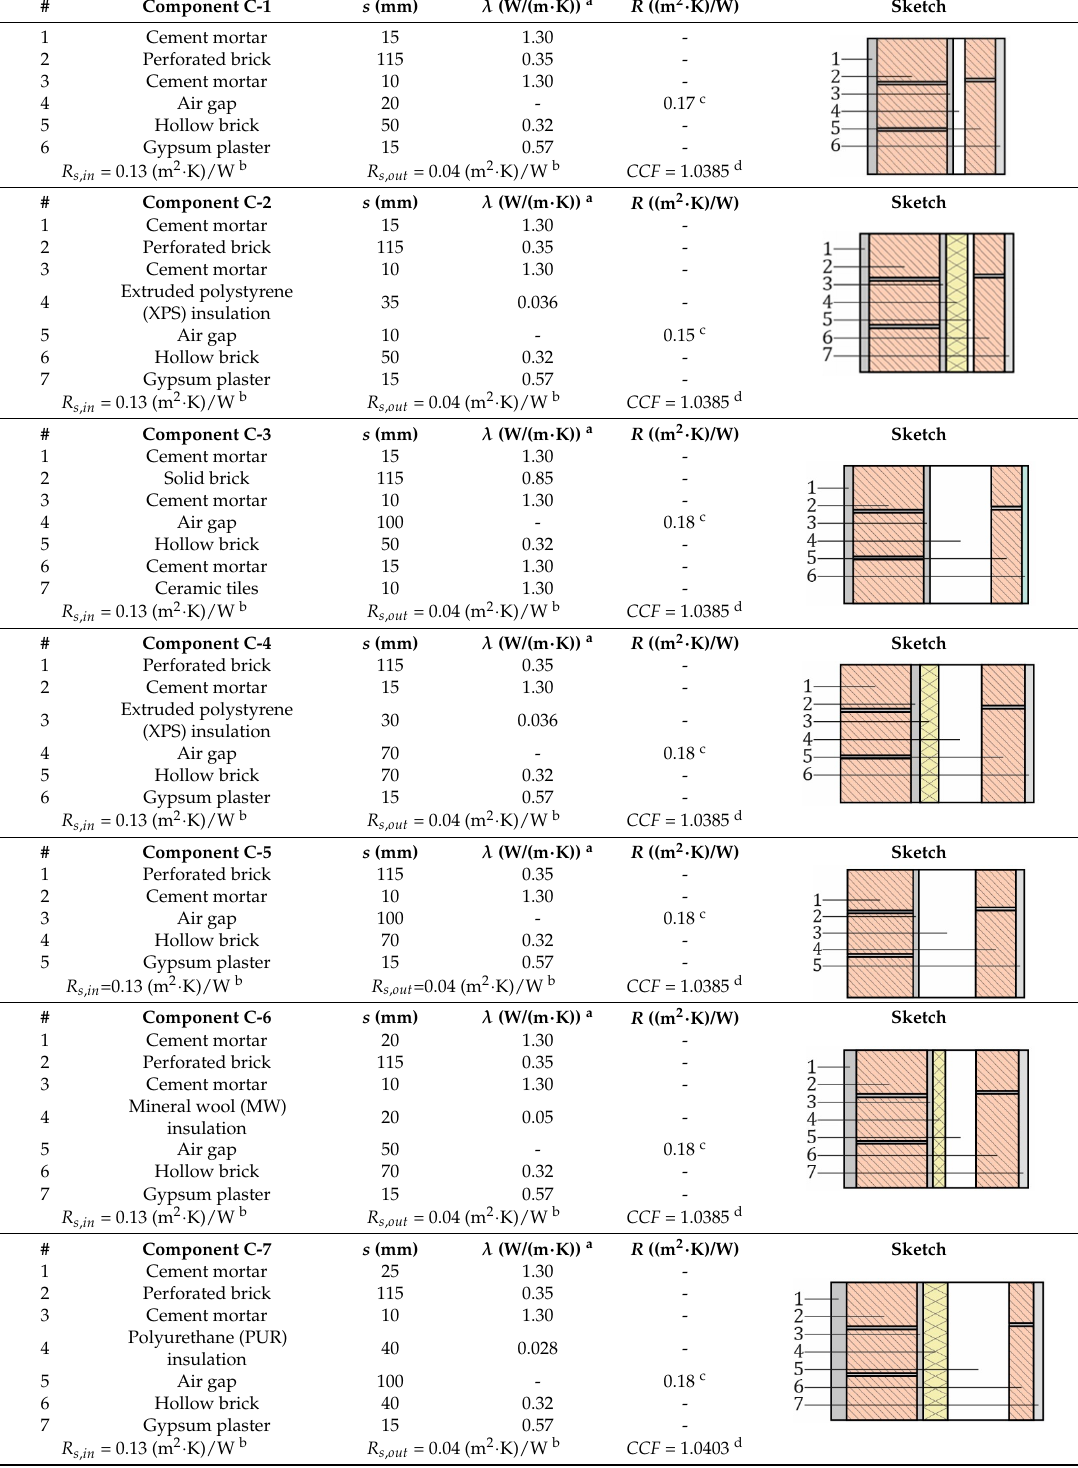
Table 2. Technical characteristics and thermophysical properties of case studies 1–8.